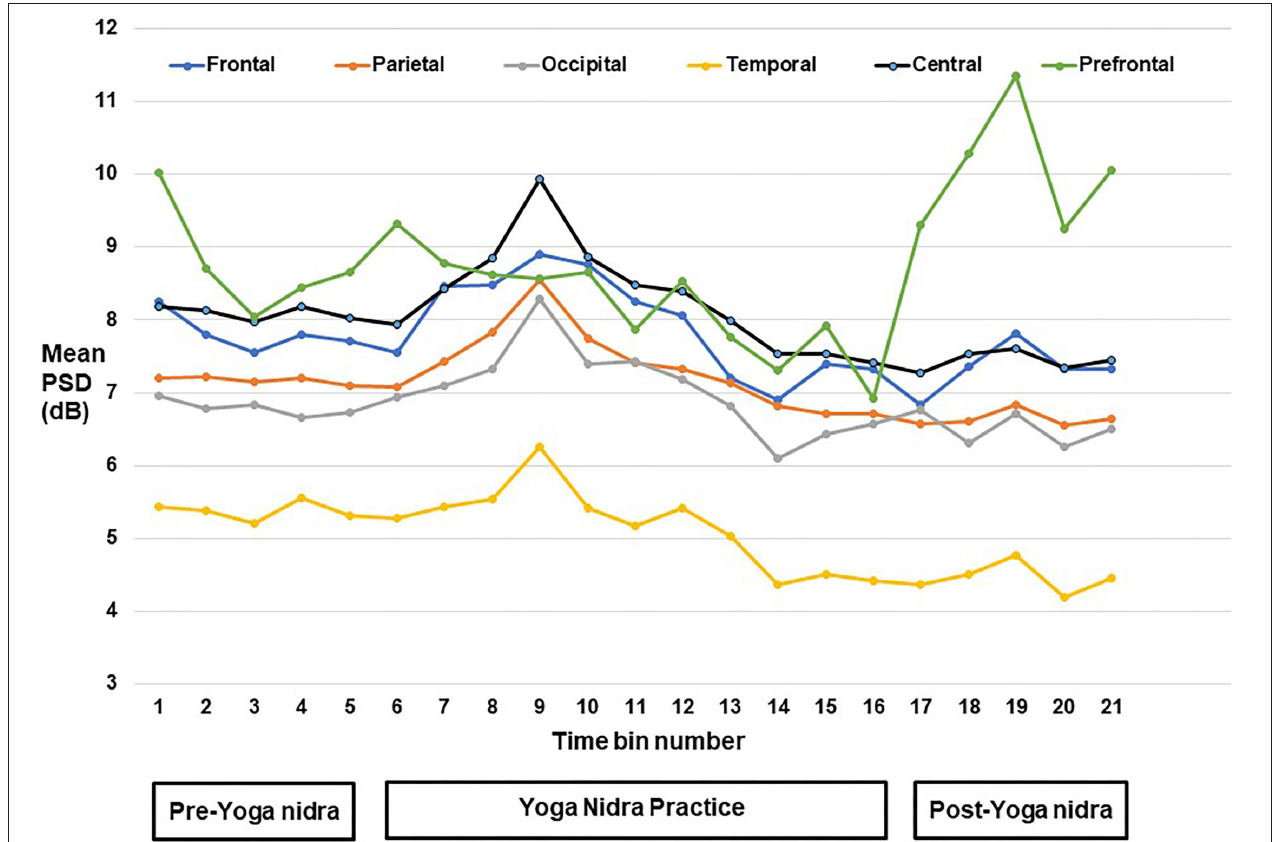
FIGURE 1 | Mean power spectral density (PSD) values of delta frequency band at pre-frontal, frontal, central, parietal, temporal, and occipital regions.